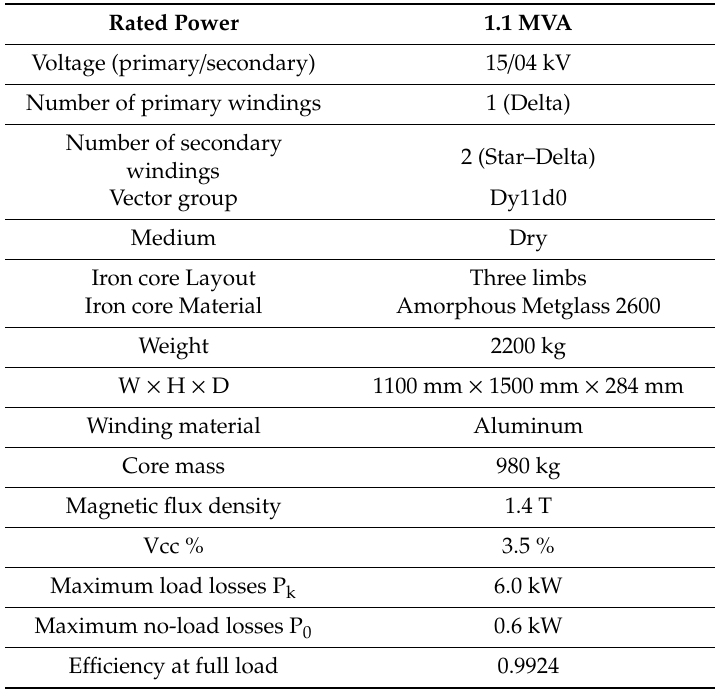
Table 5. Main parameters of 1100 kVA amorphous core transformer (AMT)